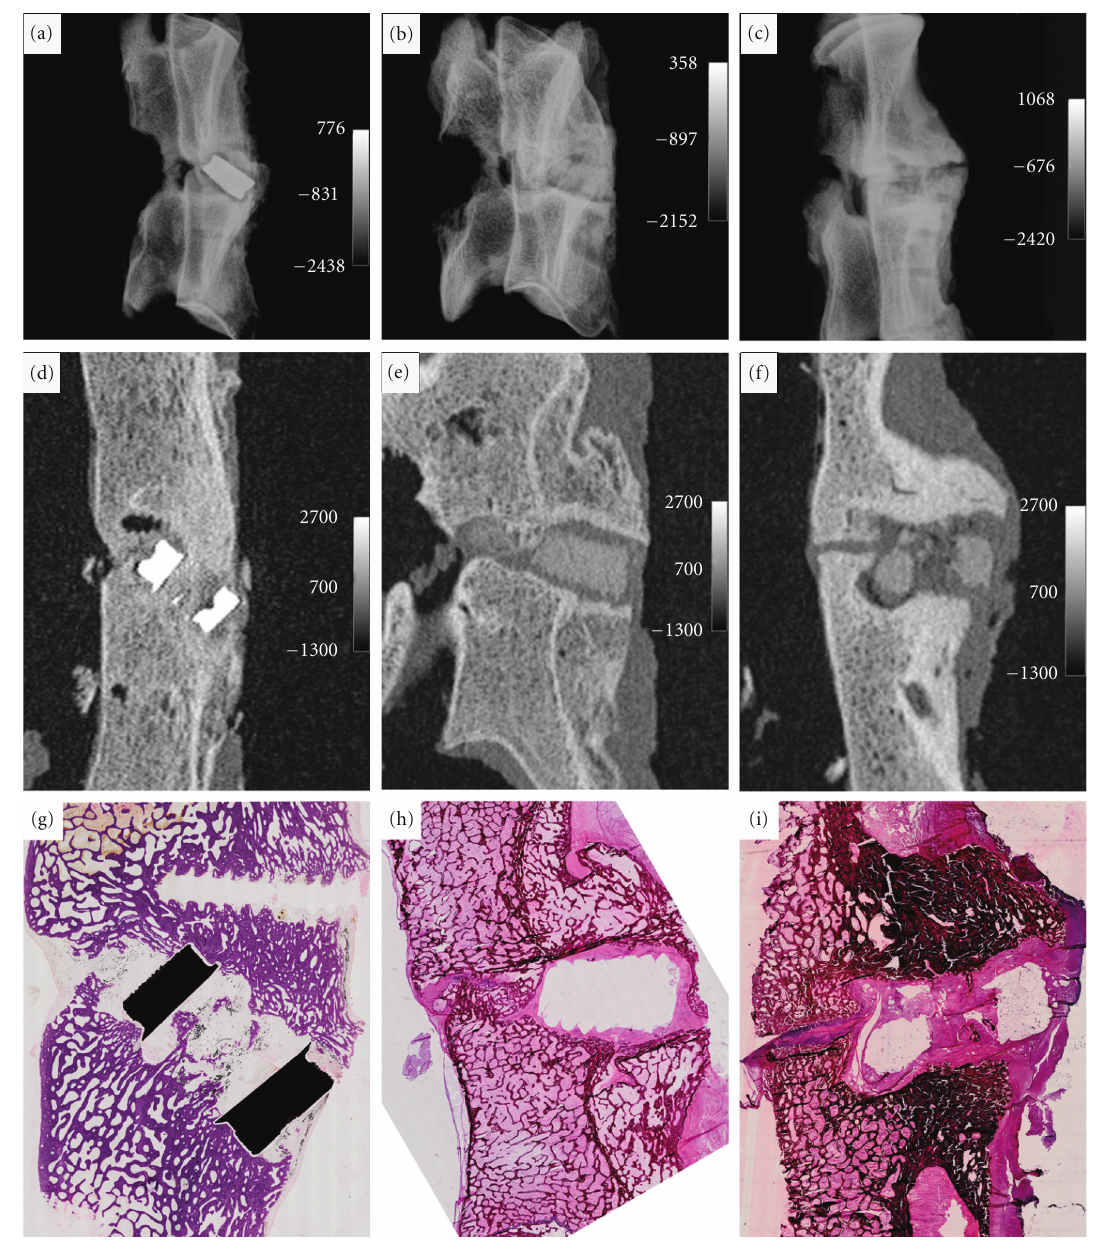
Figure 2: (a–c) Lateral plain X-rays showing aligned vertebrae at 6-month time point ((a) for control implant and (b)-(c) for composite implants). (d) Sagittal CT at the center of the control implant shows an advanced fusion. (e) Sagittal CT image shows no implant to bone contact or fusion of the adjacent vertebral bodies of the composite implant. (f) Sagittal CT image at the centre of the composite implant showed fragmentation of the implant but no migration to the spinal canal and malunion of the vertebras. (g) Hematoxylin and eosin (H&E) staining of a sagittal section at the centre of the control implant shows bone ingrowth through the implant and signs of dark fine granule surrounding the implant suggesting metallosis. (h)-(i) A dense fibrotic capsule and a mild foreign body reaction surrounded the composite implants, and no bone contact was